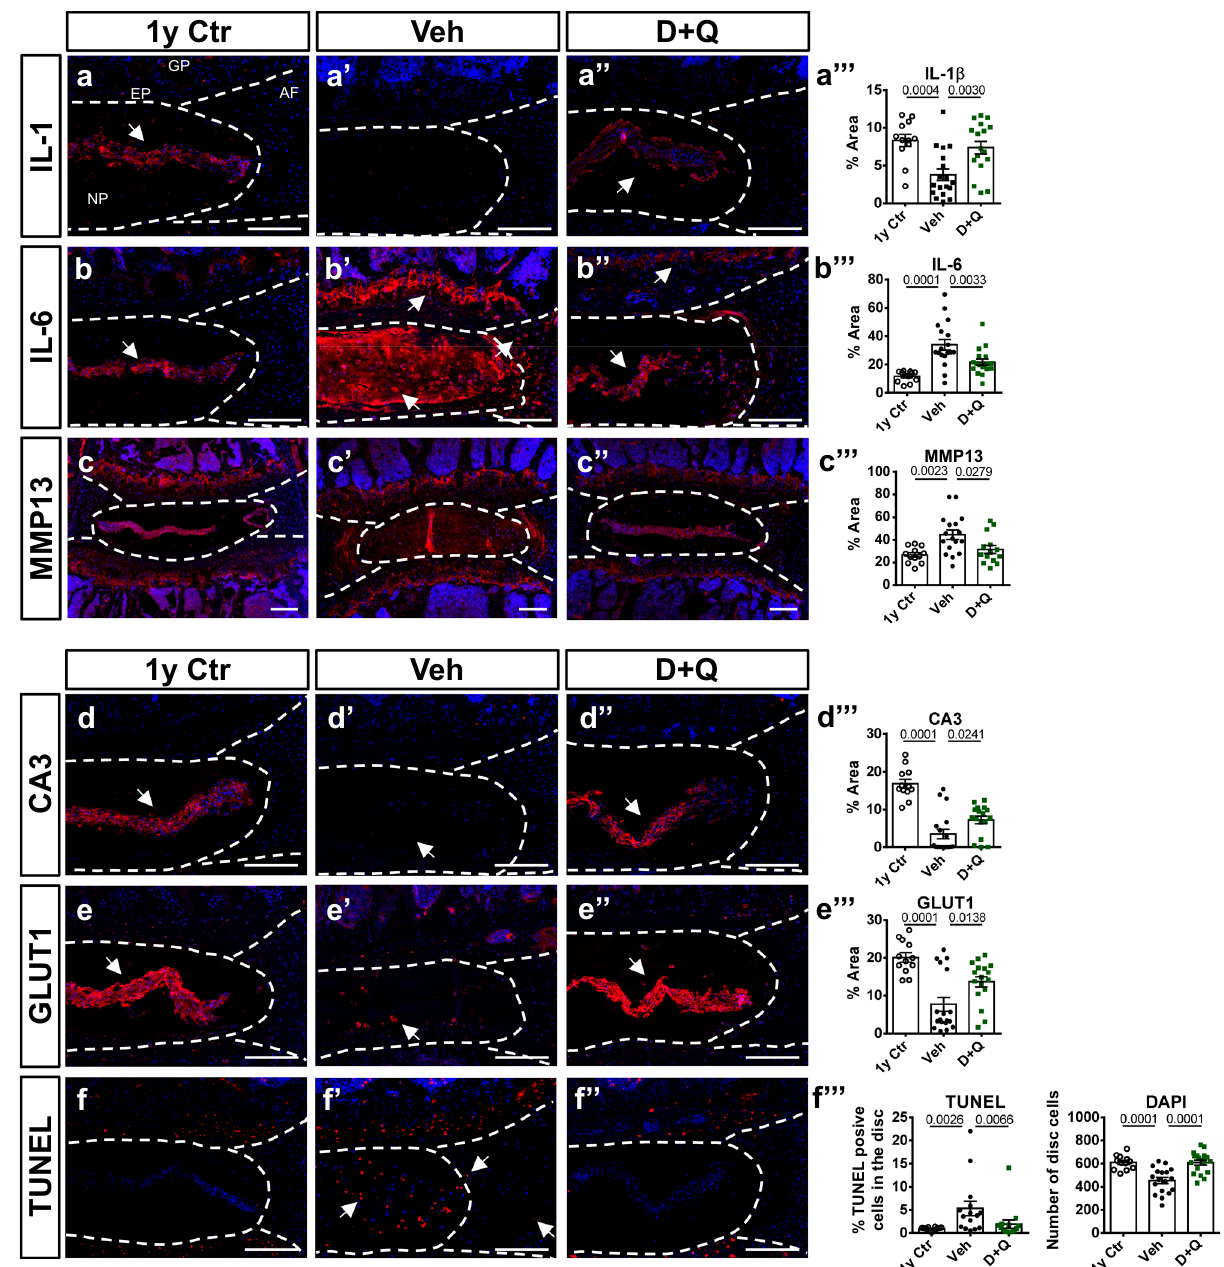
Fig. 2 D + Q treatment prevents age-dependent SASP progression and promotes NP cell phenotype maintenance and disc cell viability. a – c ”’ Immunohistological staining and staining area quanti fi cations of SASP markers IL-1, IL-6, and MMP13 in the disc compartments of 1-year-old healthy Ctr (1 y Ctr), 14 – 23 M Veh-, and 14 – 23 M D + Q-treated mice. d – e ”’ Quantitative immunostaining of NP cell phenotypic markers CA3 and GLUT1. f – f ”’ Cell death assessment in the disc compartments by TUNEL staining. Two-tailed ANOVA or Kruskal – Wallis tests were used as appropriate; n = 6 mice/group, 2 – 3 levels per mouse. Data are represented as mean ± SEM. Scale bar = 200 µ m. Source data are provided as a Source Data fi